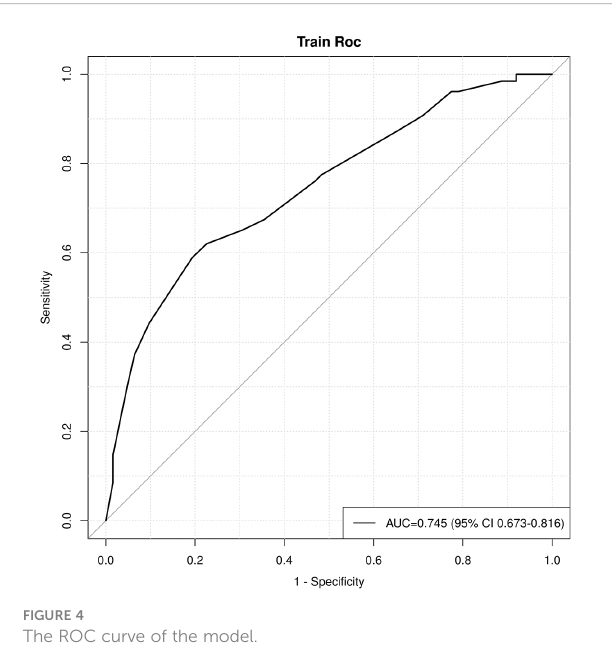
FIGURE 4 The ROC curve of the model.